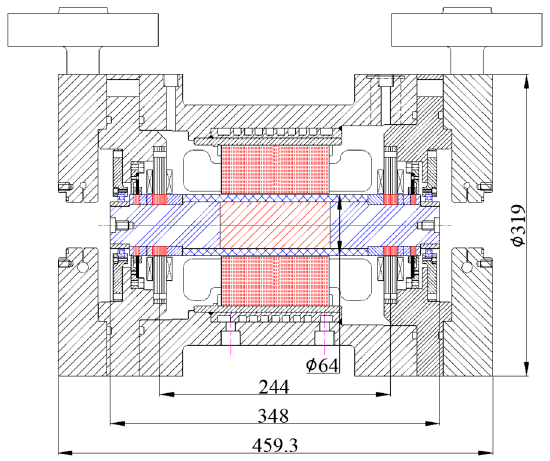
Figure 11. Design drawing of the test compressor with the AMB.